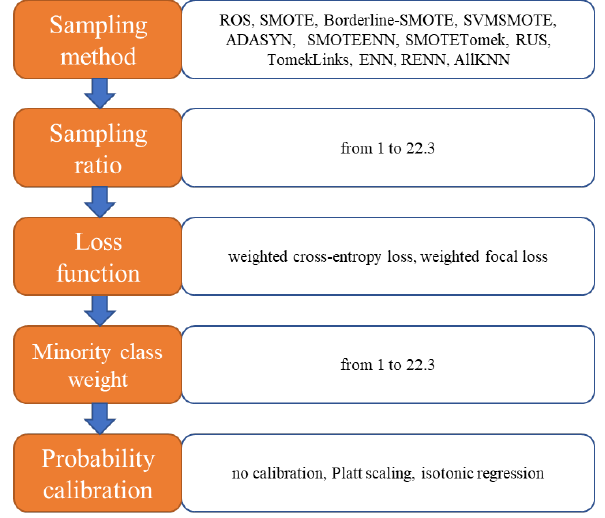
Figure 4. Five elements in the automated machine learning framework.